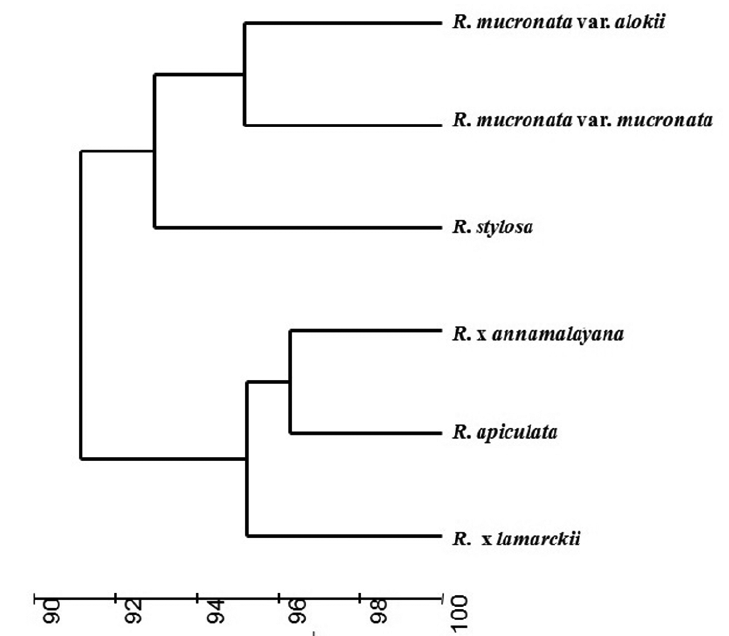
Figure 1. Cluster dendrogram (group average) showing similarity among the Rhizophora species of the